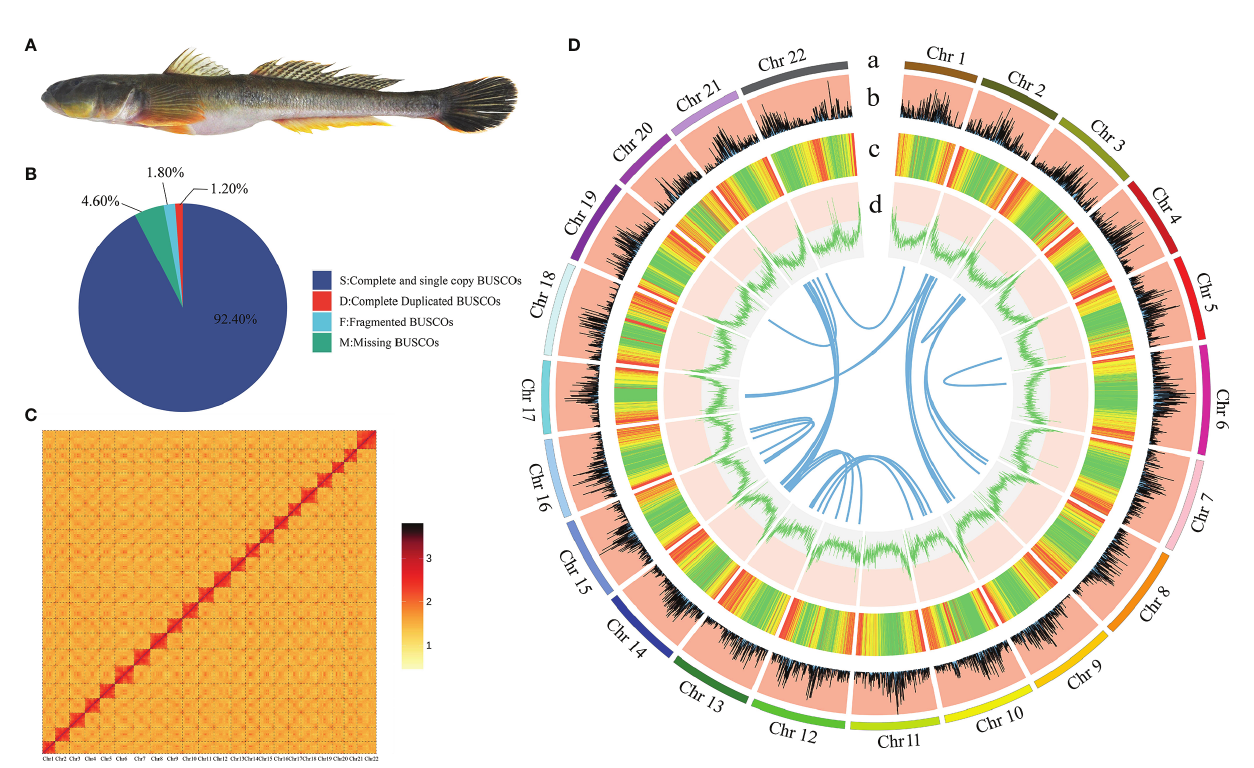
FIGURE 1 | The genome assembly and circos atlas of A. ommaturus . (A) The fi gure of A. ommaturus . (B) BUSCO analysis result of the A. ommaturus genome. (C) Statistics of the Hi-C assembly of the A. ommaturus genome. (D) Genome characteristics of A. ommaturus . From the outer circle to the inner circle: (a) chromosome length; (b) distribution of gene density; (c) distribution of repetitive elements; (d) distribution of genomic GC content. The innermost syntenic blocks are connected with blue